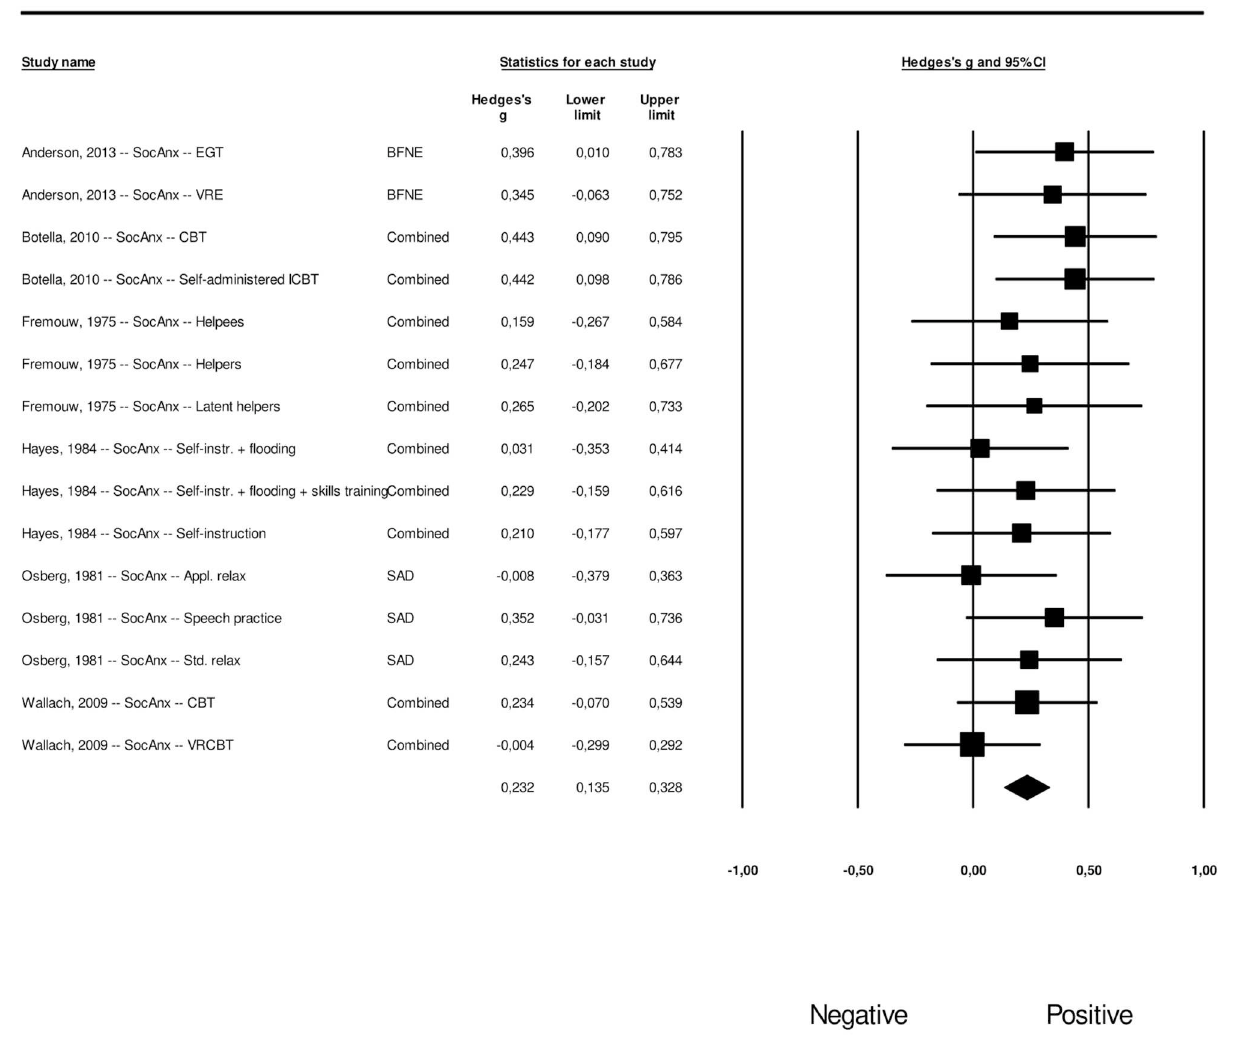
effects on FoPS (Hedges g = 0.74), corresponding to an